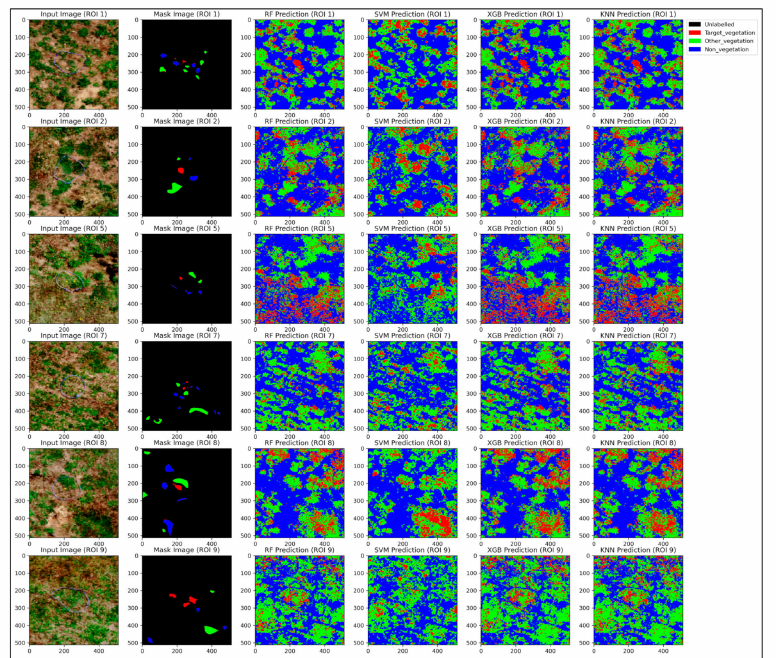
Figure 15. Prediction results from validation in different ground truth locations (ROIs) using different machine learning models.